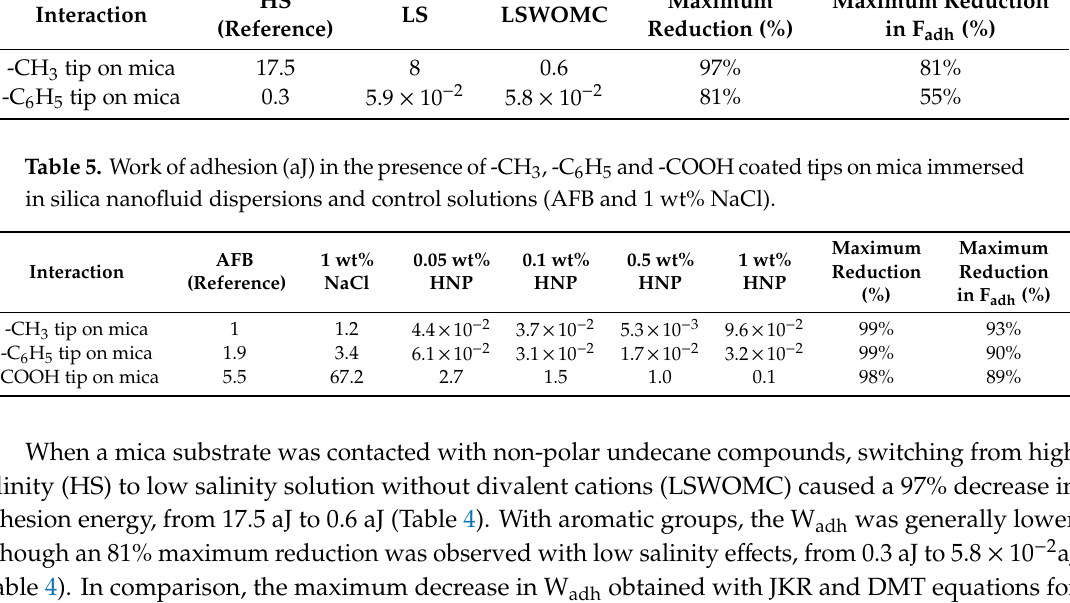
Table 4. Work of adhesion (aJ) in the presence of -CH 3 and -C 6 H 5 coated tips on mica immersed in brine at high and low salinity conditions.